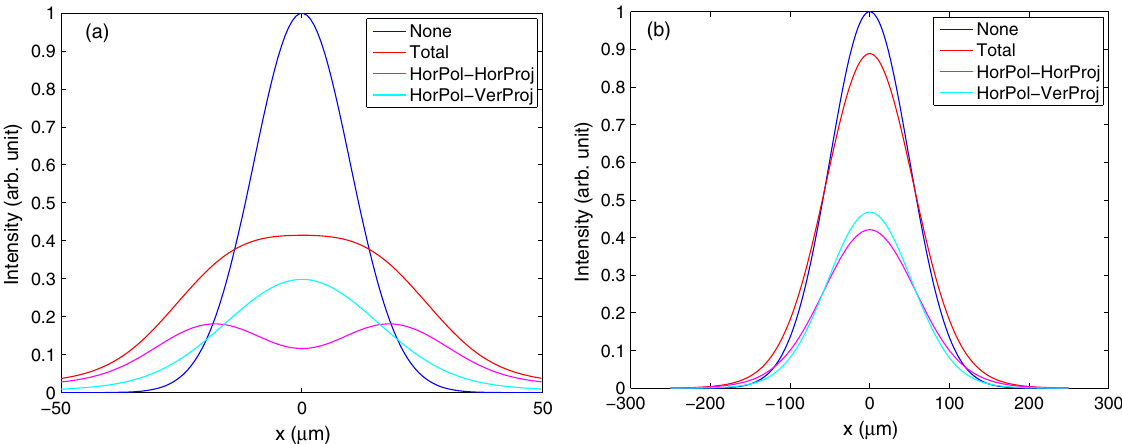
FIG. 7. Comparison plots of the original x size 10 (cid:1) m (a) and 50 (cid:1) m (b) with no convolution and with convolutions. The 50 - (cid:1) m case was convolved with the OTR PSF projections of the total ( 56 : 1 (cid:1) m ), horizontal polarization-horizontal projection ( 59 : 2 (cid:1) m ), and the vertical projection ( 53 : 4 (cid:1) m ) of the same latter